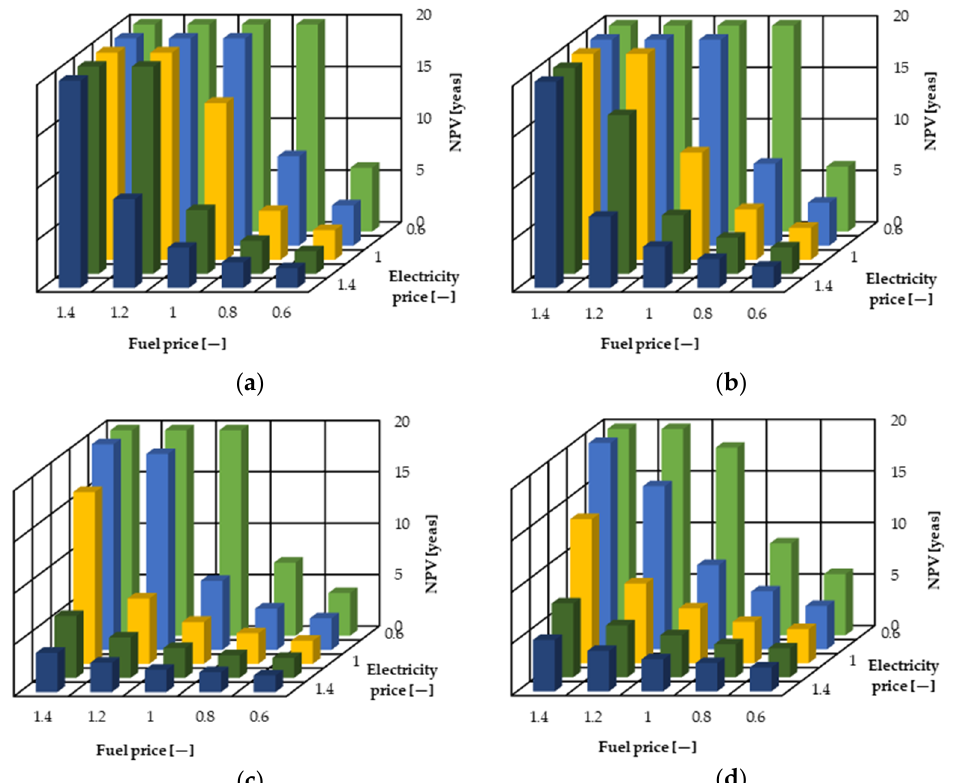
Figure 9. Dependence DPBT to relative electricity and fuel prices to current values for variant: ( a )—I, ( b )—Ia, ( c )—II, ( d )—IIa.